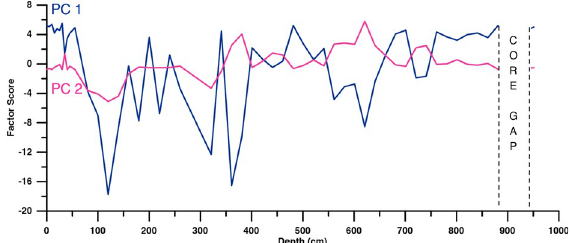
Fig 8. Depth plots of factor scores for PC 1 and PC